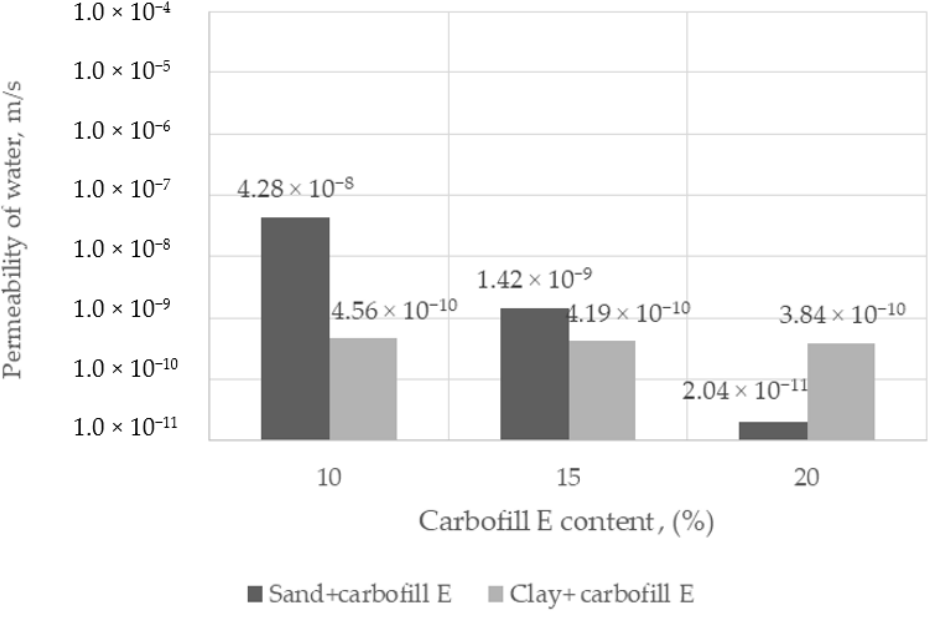
Figure 5. Water permeability of SCS with sandy and clay soil corresponding to the amount of Carbofill E binder.